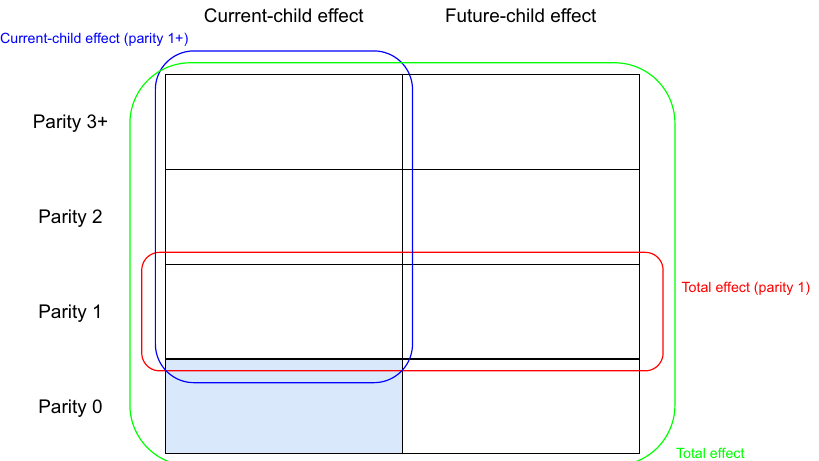
Fig. 2 Types of effect of a leave policy on fertility, by parity. The two columns correspond to the current-child effect and the future-child effect. The rows correspond to the parity of the parent. The blue, red, and green oblongs represent the current-child effect (parity 1 + ), the total effect (parity 1), and the total effect, respectively.